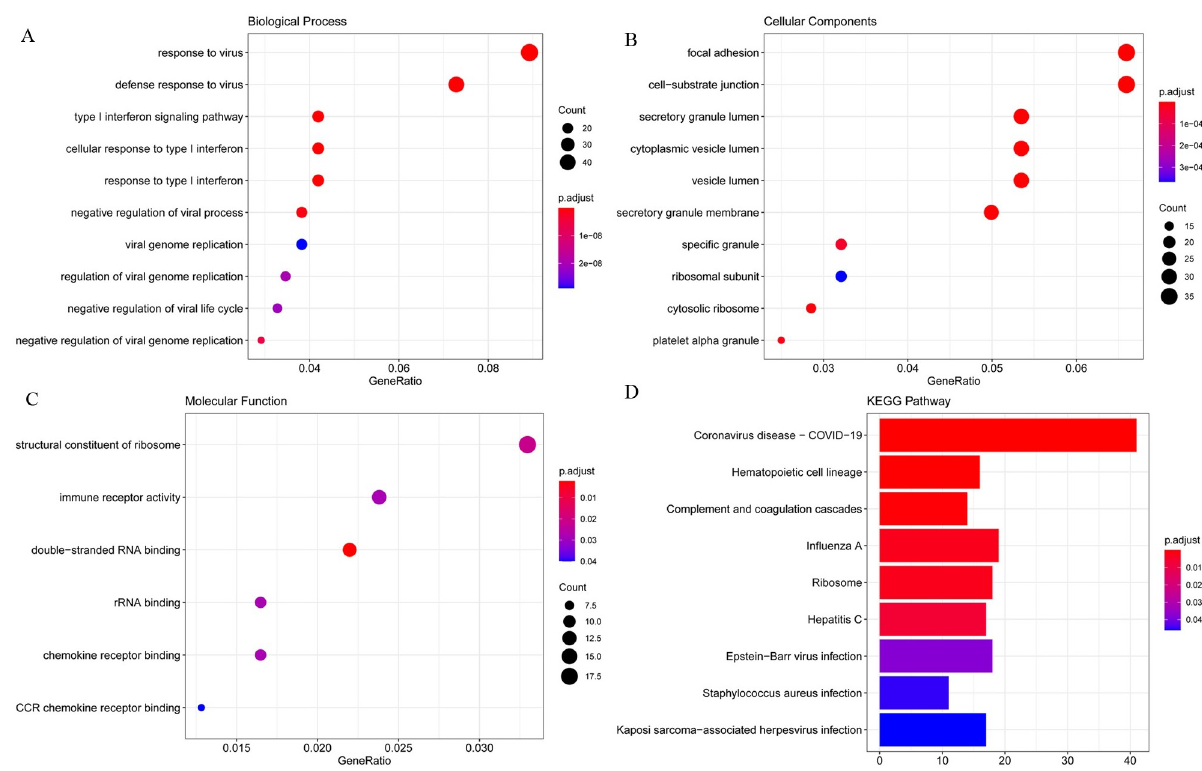
Fig 3. The GO enrichment analysis and KEGG pathways analysis of GSE28405. Abbreviation: GO, Gene Ontology; KEGG, Kyoto Encyclopedia of Genes and Genomes; DEGs, differentially expressed genes.